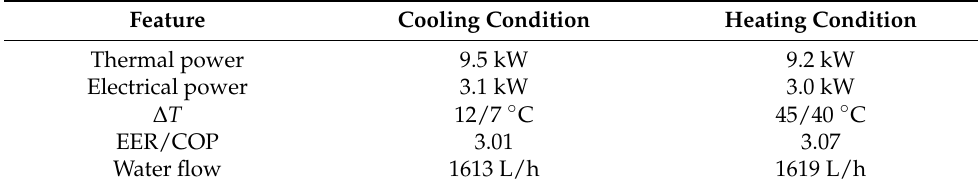
Table 6. Air-source heat pump rated performance.